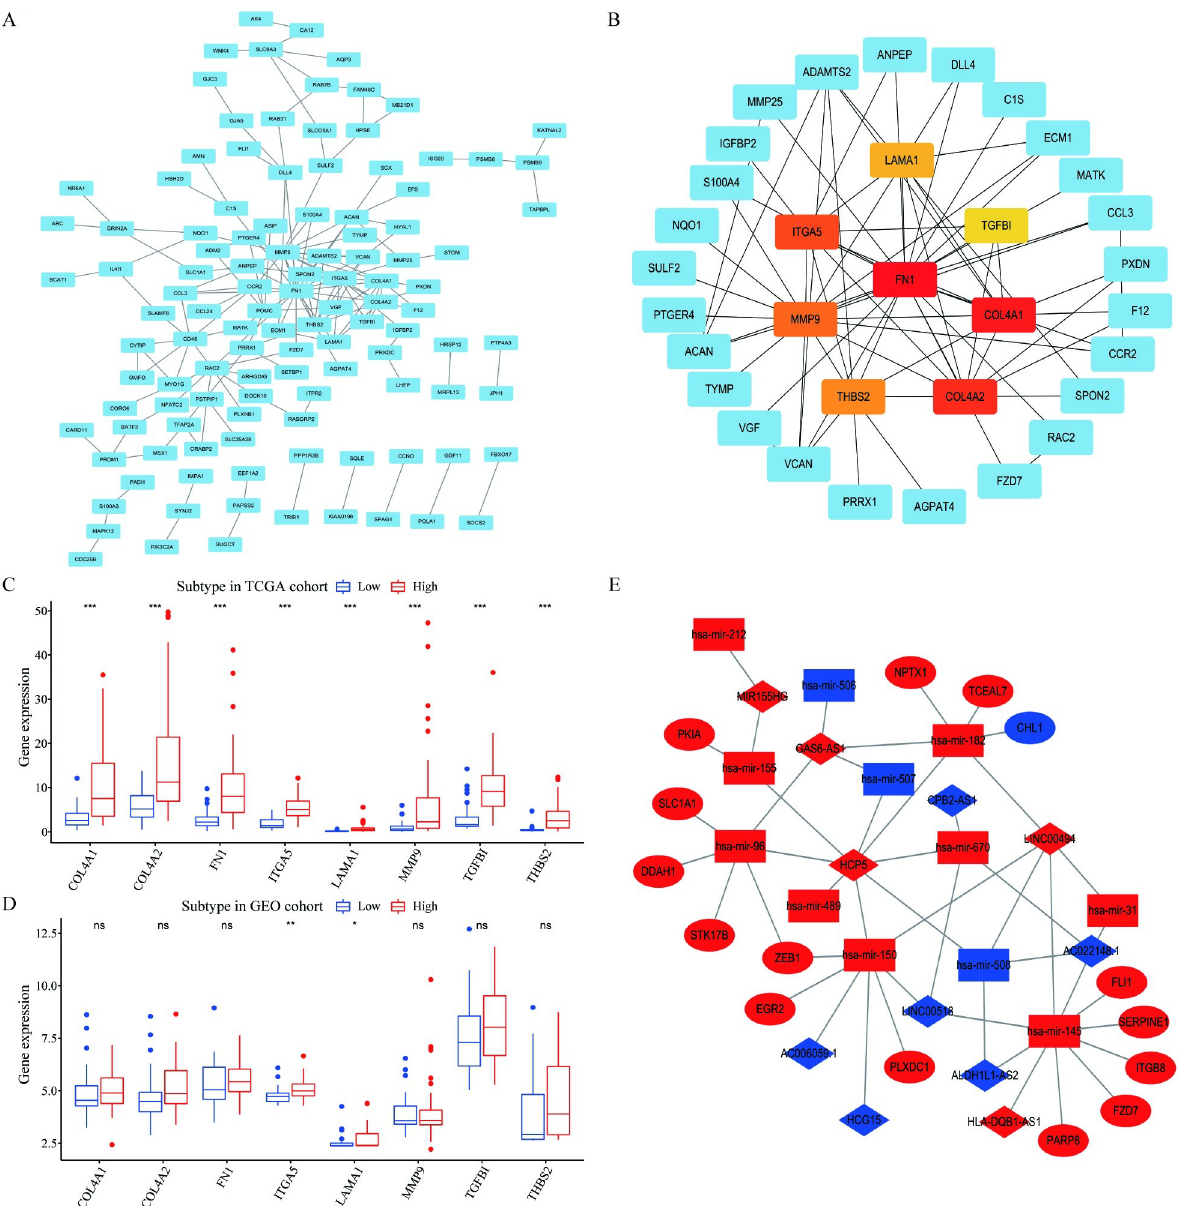
Fig 8. PPI network and visualization of ceRNA network. ( A ) STRING database was used to analyze the PPI network of 193 prognostic genes, and each node represented a distinct gene. ( B ) MCC algorithm was used to recognize hub-genes from PPI network, red and yellow nodes represented 8 hub-genes; ( C, D ) The expression of 8 hub-genes in the TCGA database and GEO database; ( E ) The ceRNA network was built based on differentially expressed mRNA, miRNA, and IncRNA. Among them, ellipse represented mRNA, diamond represented IncRNA, and square represented miRNA. Red suggests elevated gene expression and blue suggests decreased gene